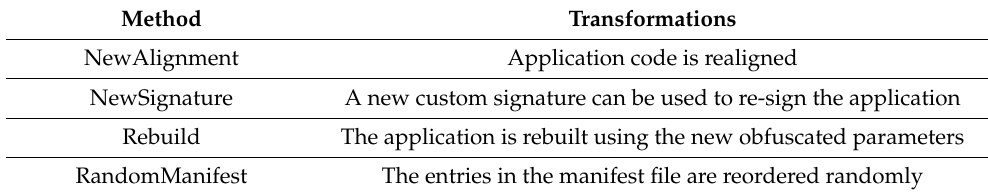
Table 1. Trivial Obfuscation Techniques.